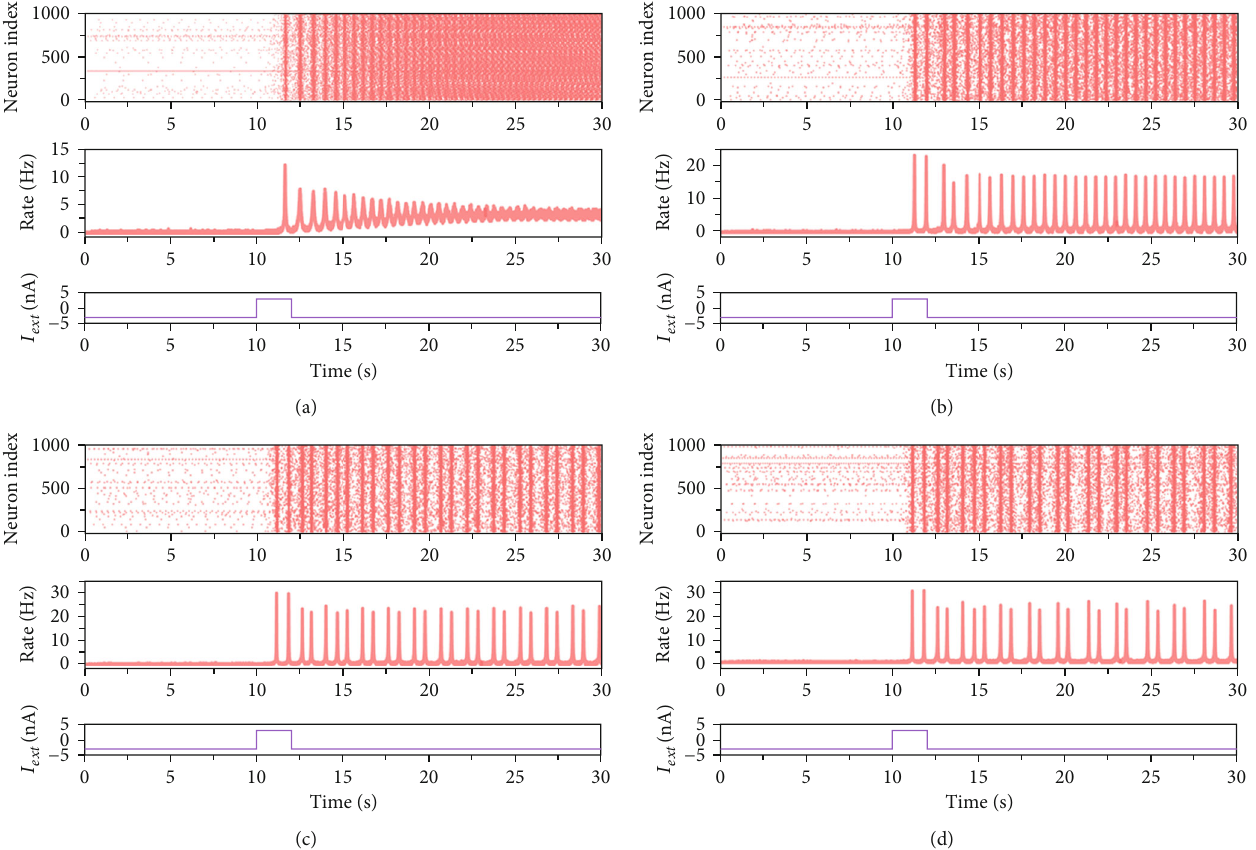
Figure 6: Activities of the network model when ð I 52 : 4 Þ (d). In each chart, the upper panel is the raster plot of 1000 randomly selected neurons in the excitatory population, the middle panel identi fi es the corresponding fi ring rate of the excitatory population, and the bottom panel gives variation of the external stimulus = 3 between 10 and 12s, and I which I ext